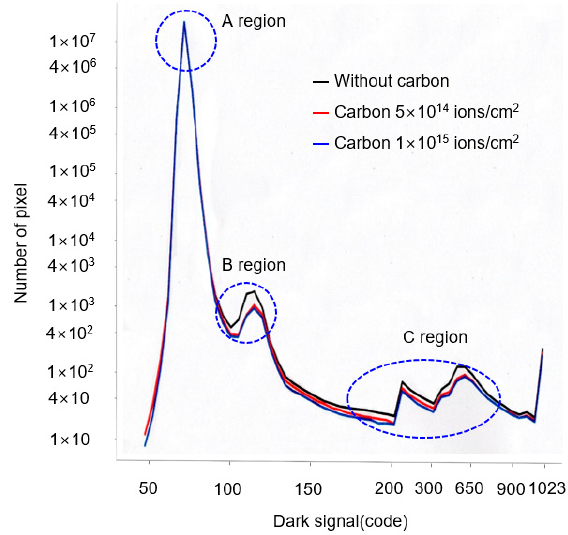
Figure 7. Dark current histogram in conditions of carbon-free, carbon dose of 5 × 10 14 ions/cm 2 , and carbon dose of 1 × 10 15 ions/cm 2 .